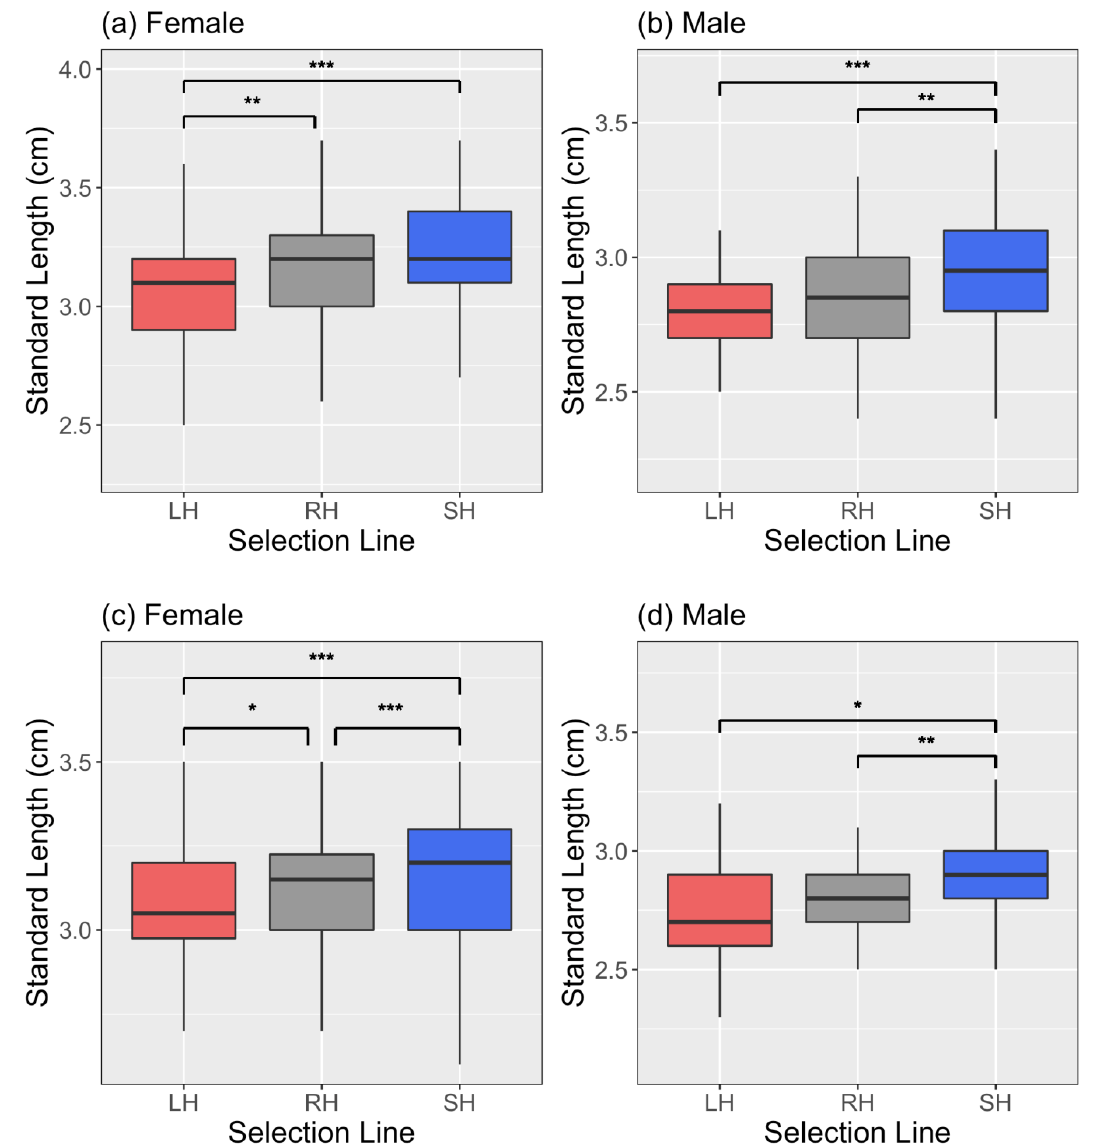
Figure 1. Comparison of body size of individuals across selection lines (Large-harvested (LH), Random-harvested (RH) and Small-harvested (SH)) among ( a ) females and ( b ) males in prezygotic preference tests, and ( c ) females and ( d ) males in spawning trials. Significant results are indicated by *. Significance codes: ( p ≤ 0.001) ‘***’, ( p ≤ 0.001) ‘**’, ( p ≤ 0.01) ‘*’.